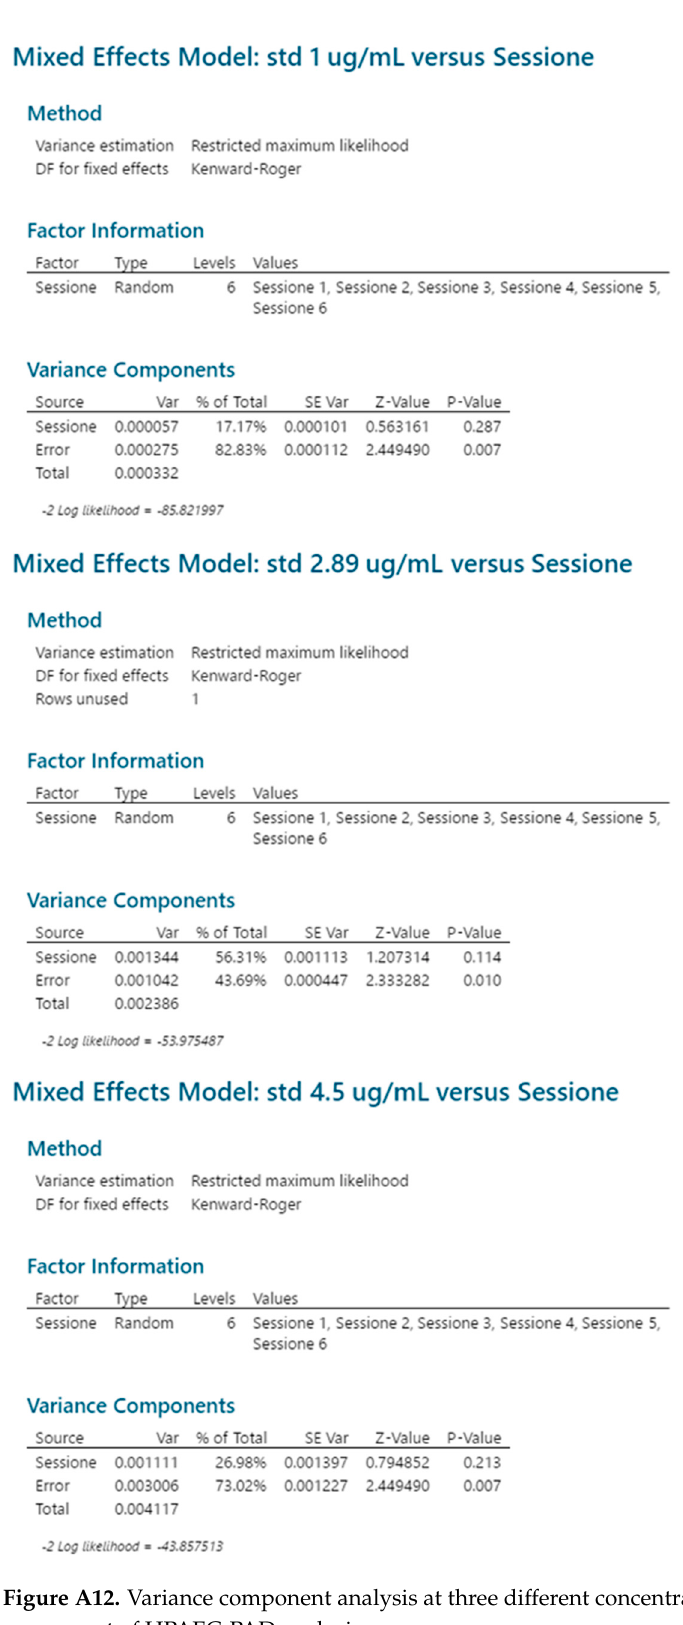
Figure A12. Variance component analysis at three different concentration levels for reproducibility assessment of HPAEC-PAD analysis.